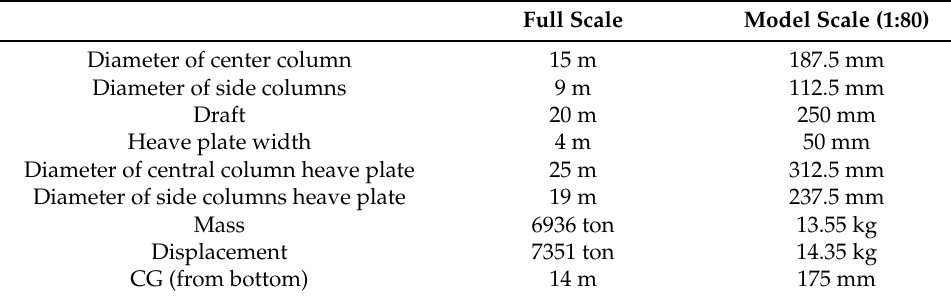
Table 1. Jappaku FOWT hull main properties.